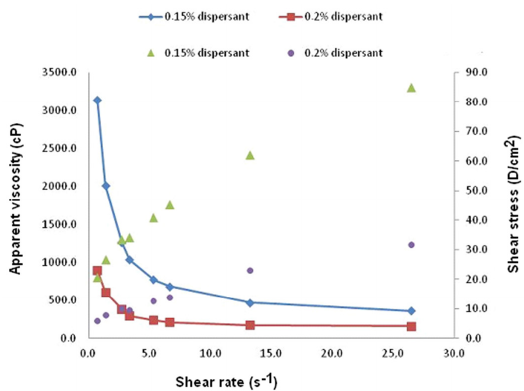
Figure 8. Rheological behavior of spodumene. 0.15% and 0.2% of dispersant.